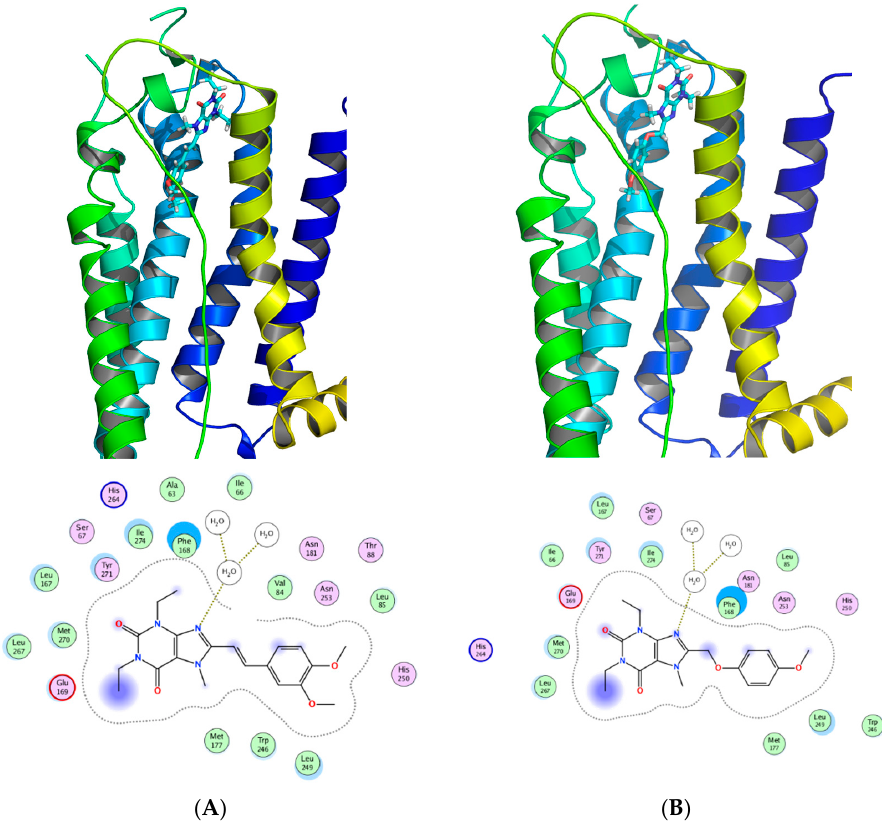
Figure 13. Docking of ( A ) istradyfilline (KW-6002) and the ( B ) phenoxymethyl-xanthine derivative in the adenosine A 2A receptor (3EML). The two compounds share a binding motif with the coordination with the water in the binding pocket of adenosine A 2A receptor.